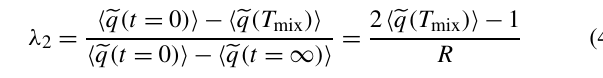
Figure 16. (a) The boundaries between mixing types on the Da − R plane designed according to criteria λ 1 = T mix between mixing types on the Da − R plane designed according to criterion λ 2 = 2 corresponding to 2% deviation from the initial mean volume